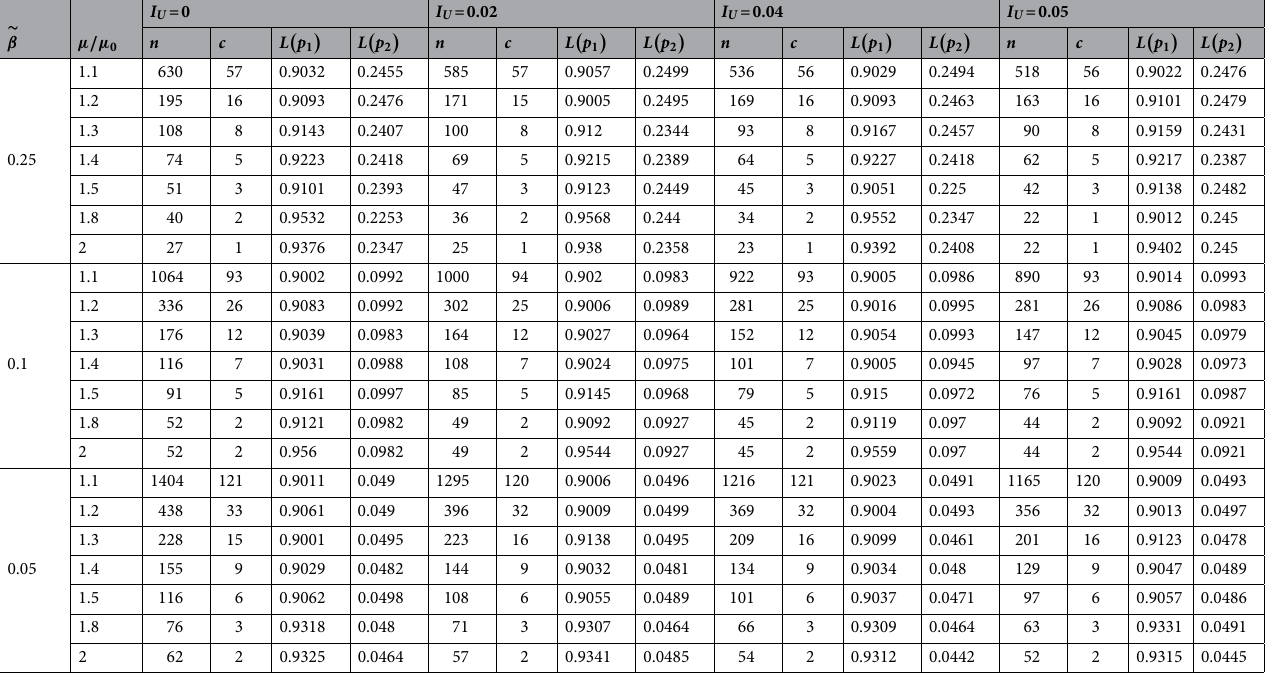
∼ α = 0.10 ; β = 2.7857 and a = 0.50 .